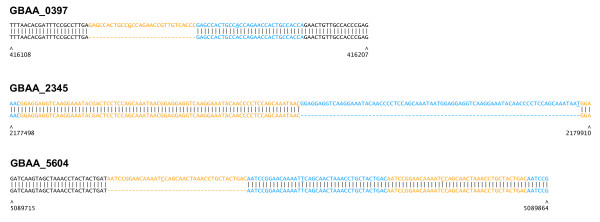
Details of selected B. anthracis Sterne false-positive SNP calls. Sequence alignments of (top) B. anthracis Sterne versus (bottom) Ames ancestor. Sterne chromosomal coordinates are given below the alignment. Repeat units are colored in alternating blue and orange text. Bases that differ from the repeat consensus sequence are underlined.